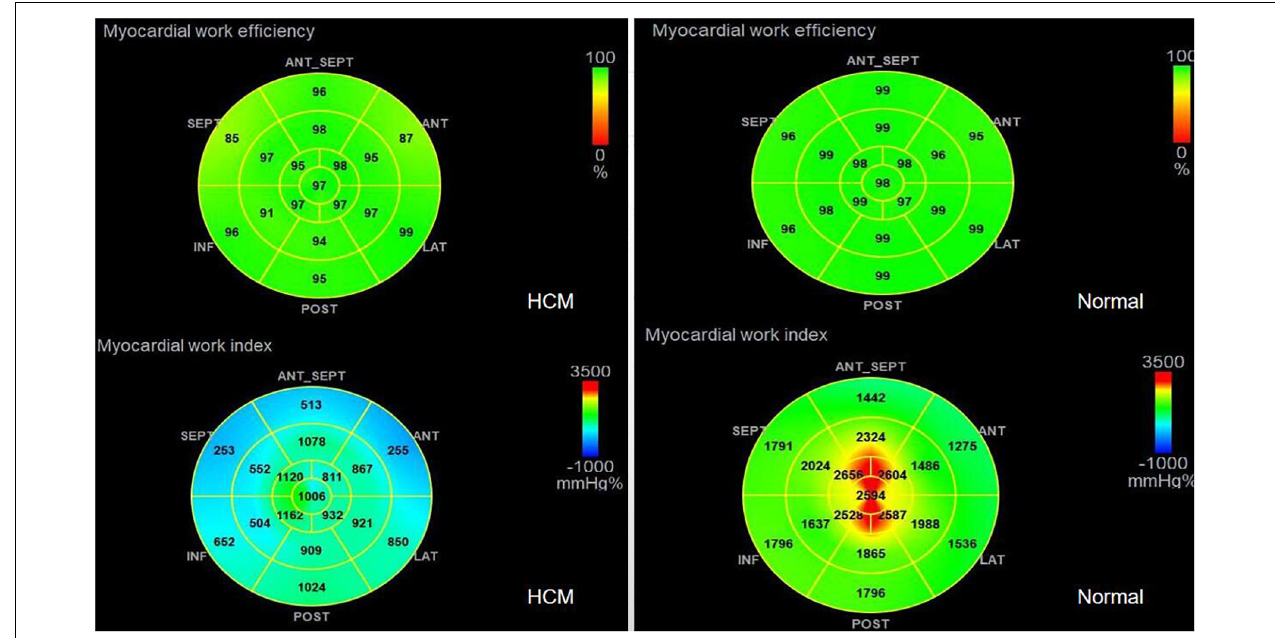
FIGURE 2 | Comparison of GWE and GWI in HCM and Normal group.